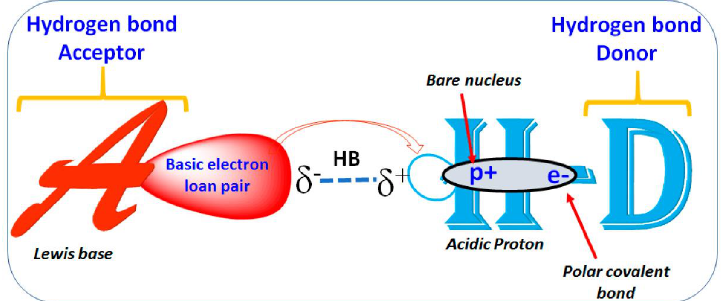
Figure 2. The pictorial illustration of hydrogen bond interaction, where HB acceptor/donor can be an F, O, N, or S atom in the molecule. Electron polarization and exposure of a positive proton on either side are shown schematically.